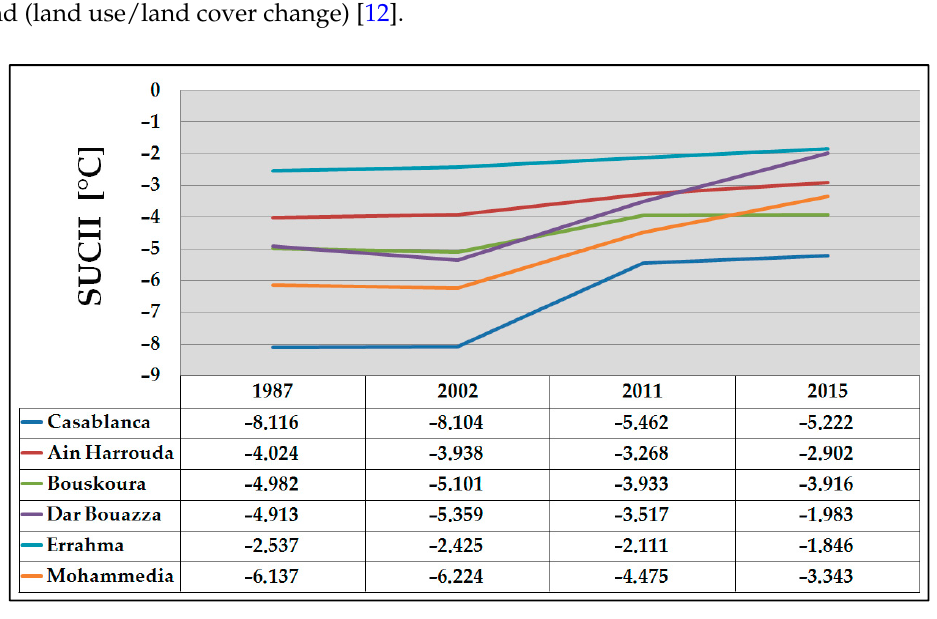
Figure 12. Variation of minimum winter SUHII (°C) from 1987 to 2015 (obtained from winter SUHII in 1987, 2002, 2011 and 2015).